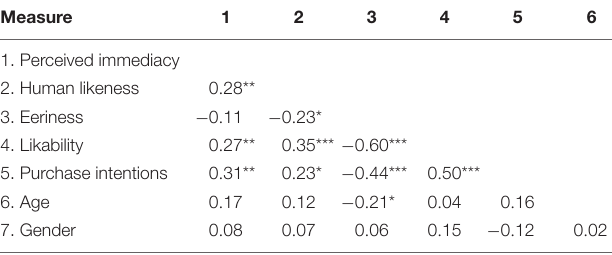
TABLE 1 | Zero-order correlations between the main measures.